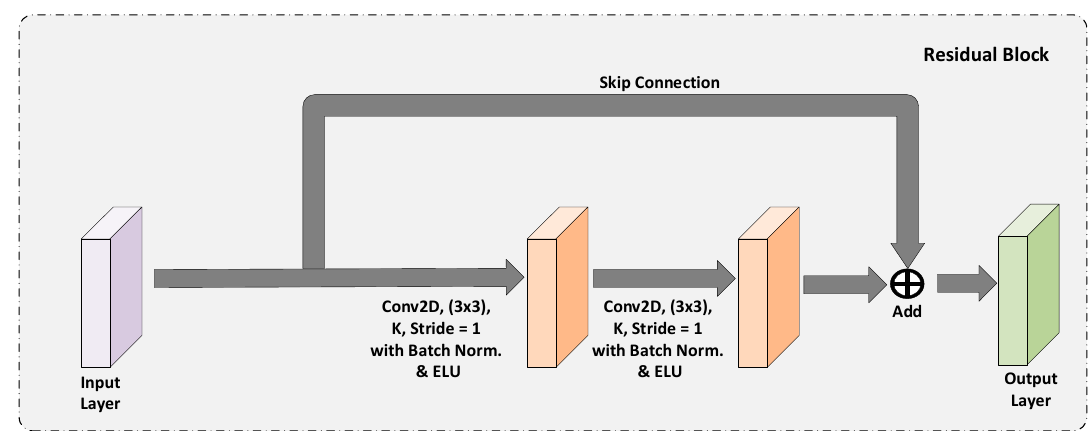
Figure 1. The overview of the Residual Block used.